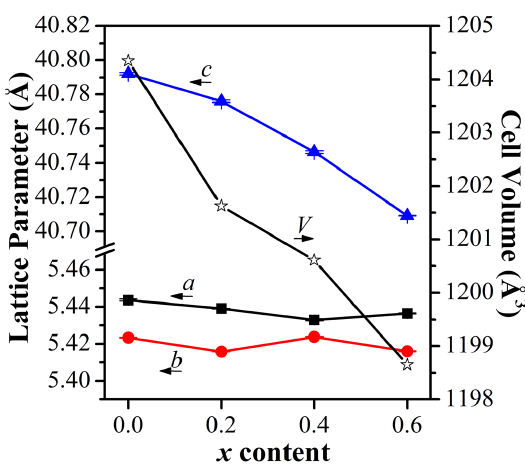
Figure 3. Lattice parameters and cell volume of single-phase Ca Bi LaTi Mn O obtained from XRD refinement 1-x 3+x 4-x x 15